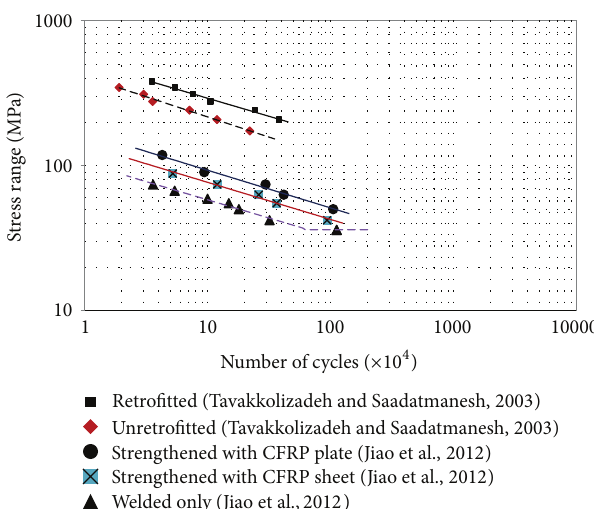
Figure 6: S-N curve for steel beam strengthened with nonpre- stressed CFRP [14, 40].